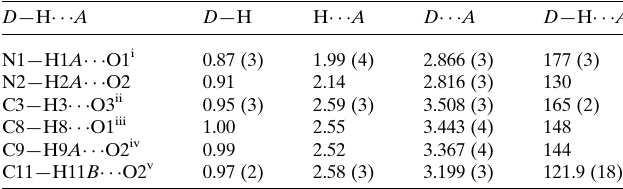
Table 1 Hydrogen-bond geometry (A˚ , (cid:3) ).